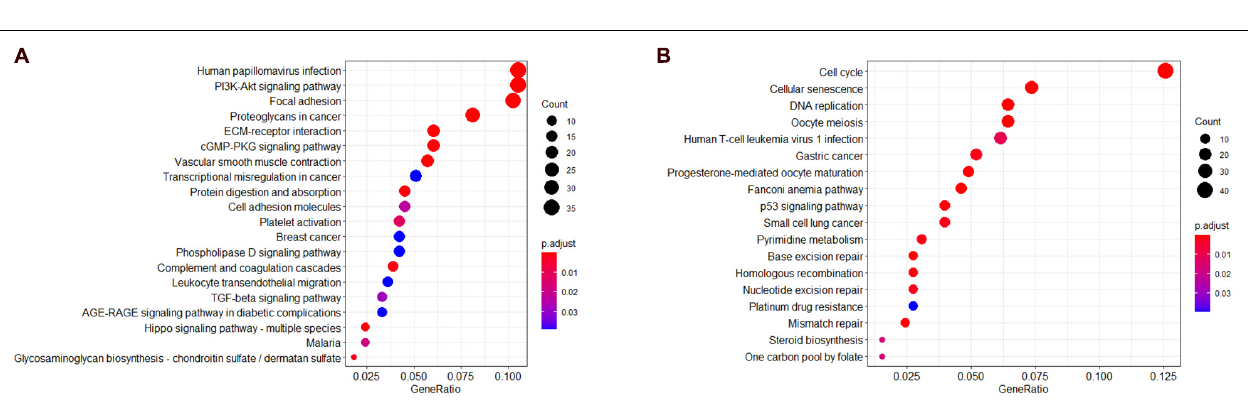
FIGURE 4 | Gene ontology (GO) and pathway enrichment analysis. (A) GO analysis of all module genes (the top five categories were presented). (B) GO analysis of the genes in the yellow module (BP, biological process; CC, cellular component; MF, molecular function). (C) GO analysis of the genes in the green module.